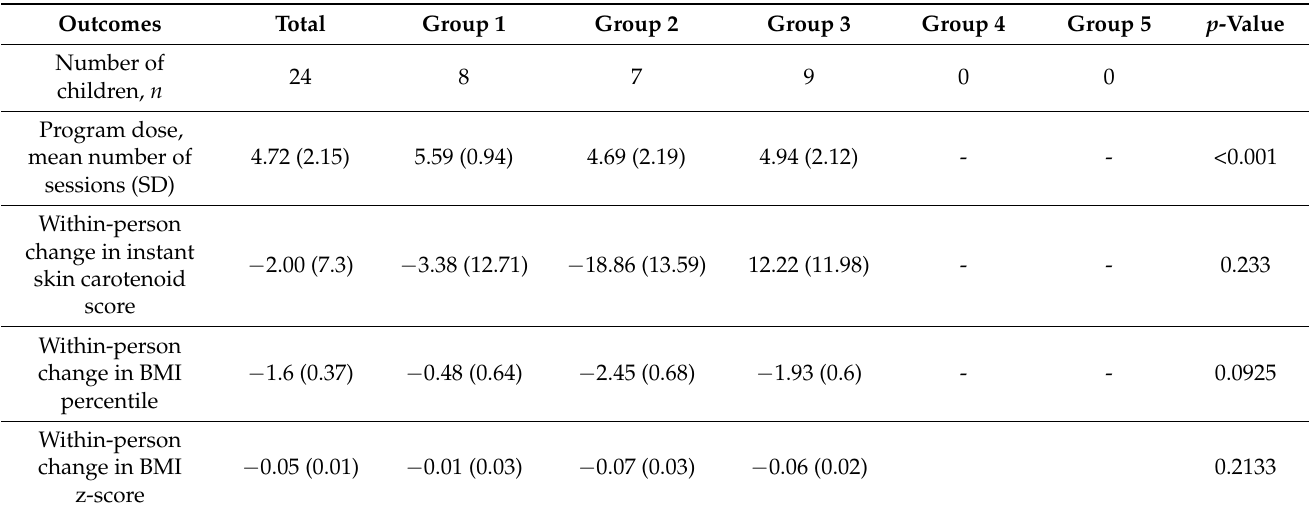
Table 3. Descriptive statistics for within-person change in child nutrition outcomes at maintenance for Mexican-heritage children.